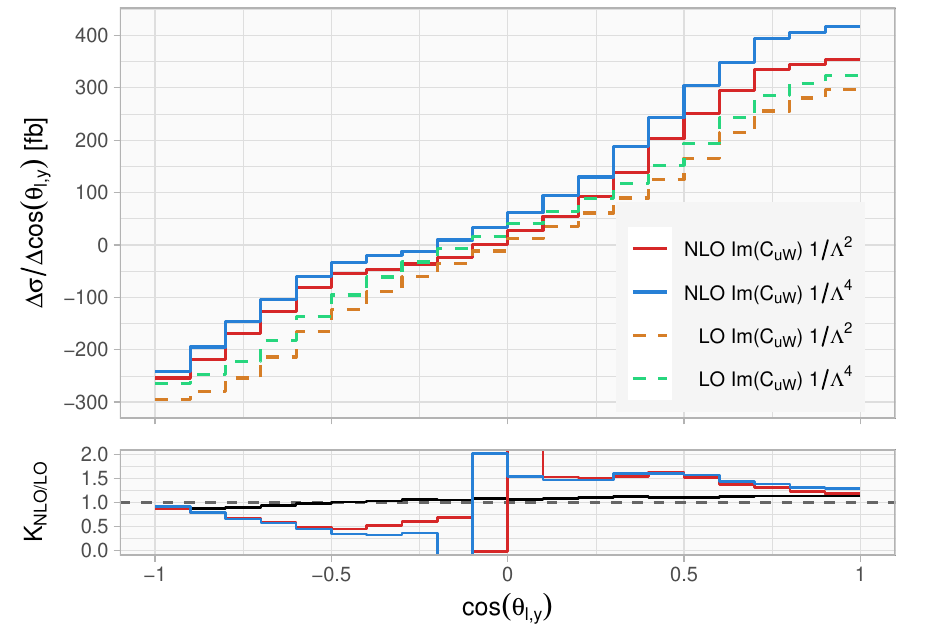
Figure 12. Distribution of cos (cid:18) l;y for the pure SMEFT contribution with Im C 33 1000 GeV. Shown are results at LO and NLO in QCD and at 1 = (cid:3) 2 in the SMEFT as well as higher order e(cid:11)ects 1 = (cid:3) 4